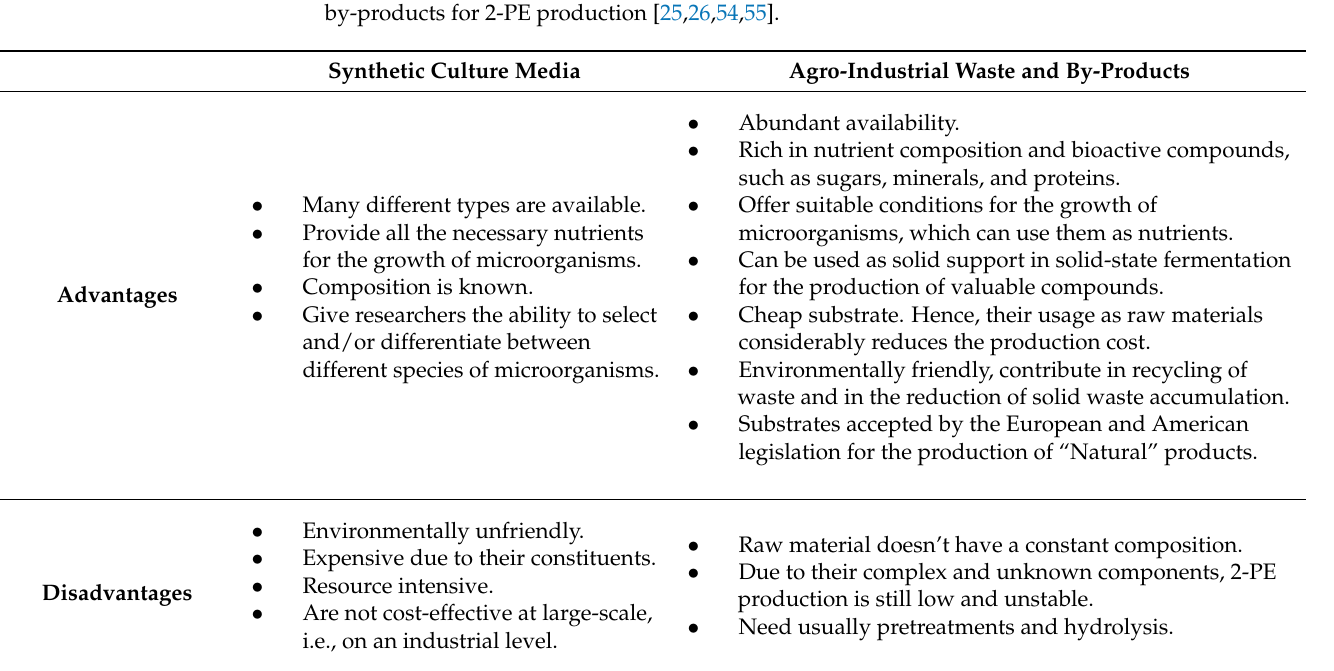
Table 1. Advantages and disadvantages of using synthetic media versus agro-industrial waste and by-products for 2-PE production